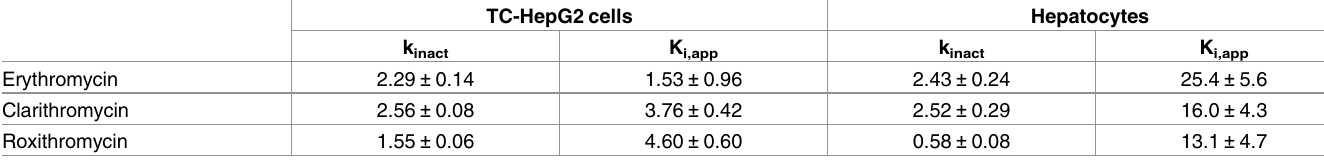
Table 3. Determination of k inact and K i,app for metabolism-dependent inhibition of CYP3A4 by macrolides. Apparentinactivationrates (k obs ) were esti- mated graphicallyfrom the slope of the plot for the natural log of enzyme activity remainingafter preincubation against preincubation time and were corrected for any loss of activity in the absenceof the inhibitor.k inact and K i,app values were obtainedfrom a doublereciprocalplot of k obs againstinhibitorconcentration. Data represent means ± S.D. of triplicate